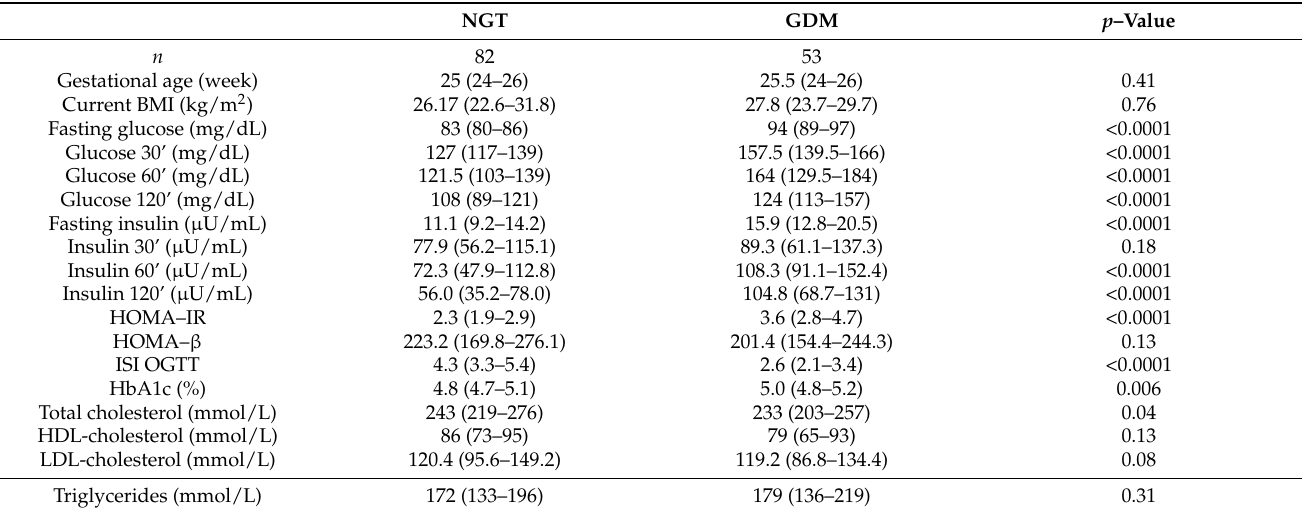
Table 2. Clinical characteristics of the groups studied in the 2nd